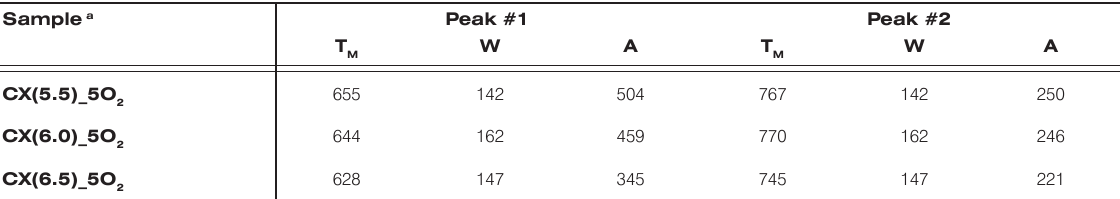
-TPD spectra using a multiple Gaussian 2